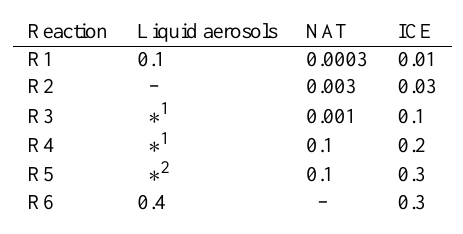
Table 5. Reaction probabilities ( γ ) for heterogeneous reactions